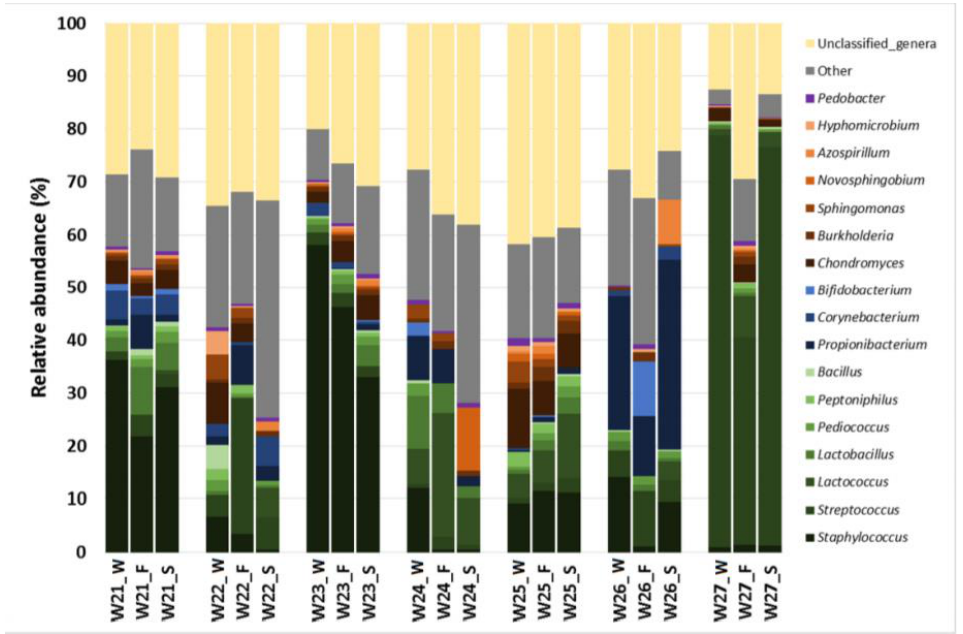
Figure 7. Comparison of individual profiles of the relative abundance of the most abundant bacterial genera in the whole milk (W) samples provided by each woman ( n = 7; W_21 to W_27) and their fractions: the fat layer (F) and the skimmed milk (S).